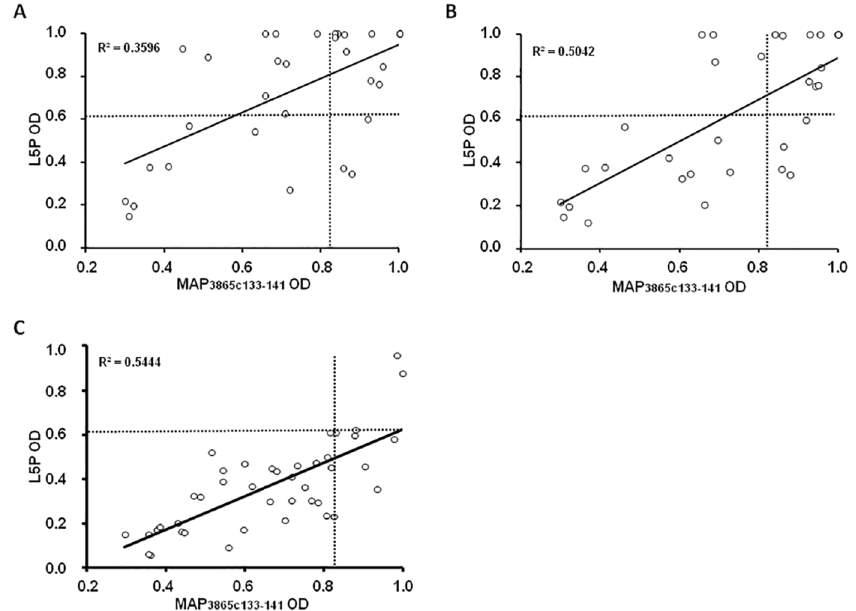
Fig 2. Correlation between Abs recognizing MAP-derived epitope and L5P antigen in children at risk for T1D and HC. The distributions represent correlations between Abs against MAP3865c 133 – 141 and L5P in T1D at-risk subjects including samples of the first time-point (A) or the last time-point (B) and HC (C). Each circle corresponds to Abs detected in one sample. The dotted lines indicate cut-off values used in each assay to discriminate between positive and negative samples. R 2 coefficients are given for each